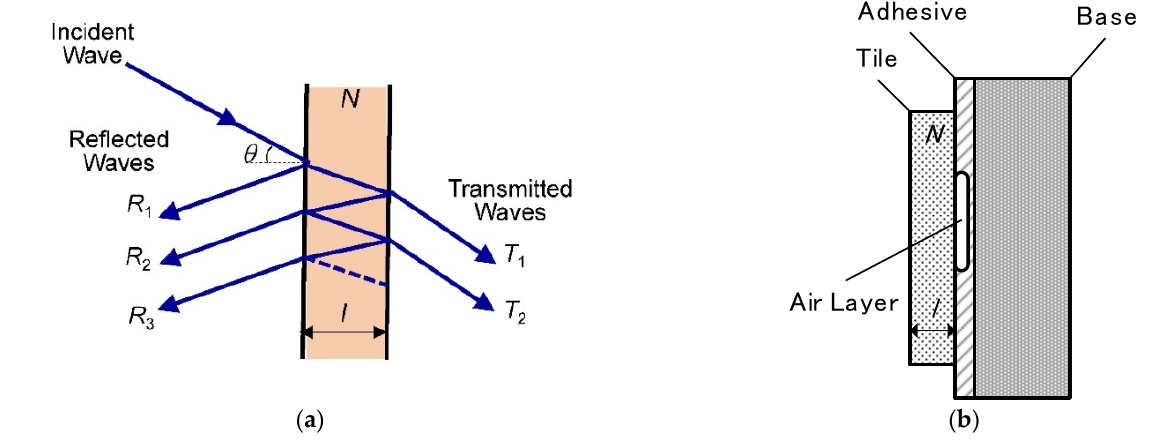
Figure 1. ( a ) Model of Fabry–Perot interferometry; ( b ) model of present subject.